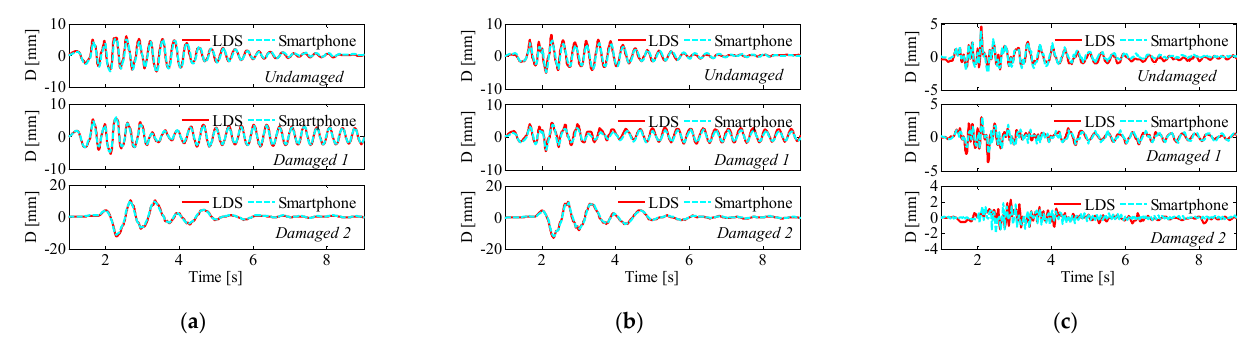
Figure 6. The displacement time history responses as collected by the LDS and smartphones, for the undamaged case and two damaged cases, were compared to show good agreement, except for the results from the third-floor damaged case. Representative results from the ( a ) first, ( b ) second, and ( c ) third floors were overlaid.